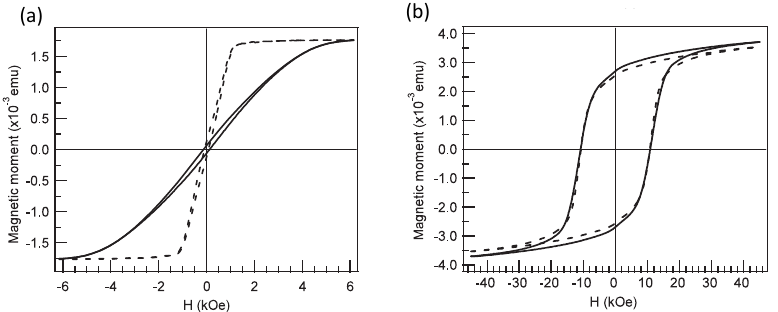
Figure 3. 80nm diameter Co 0 . 47 Pt 0 . 53 ordered nanowires after annealing at 700˚C; ( a ) XRD pattern; the superstructure peaks, as (001) or (110), reveal an ordered phase of the alloy; ( b ) room temperature hysteresis loops. The curves were obtained with the magnetic field parallel (——) and perpendicular (- - - -) to the wire’s axis.